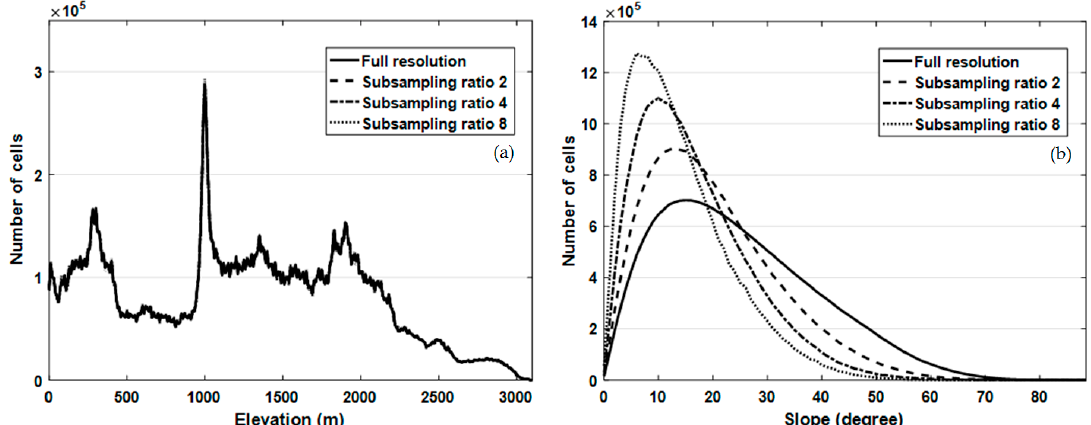
Figure 15. Effect of DEM subsampling on elevation and slope histograms. The distributions of elevation ( a ) and slope ( b ) are computed for an input DEM (obtained from a SPOT-4 stereo pair over Lebanon with 10 m ground sampling distance) and for subsampled DEMs with the increasing ratios of 2, 4, 8. A higher subsampling ratio leads to larger and less numerous cells (source: [90]).